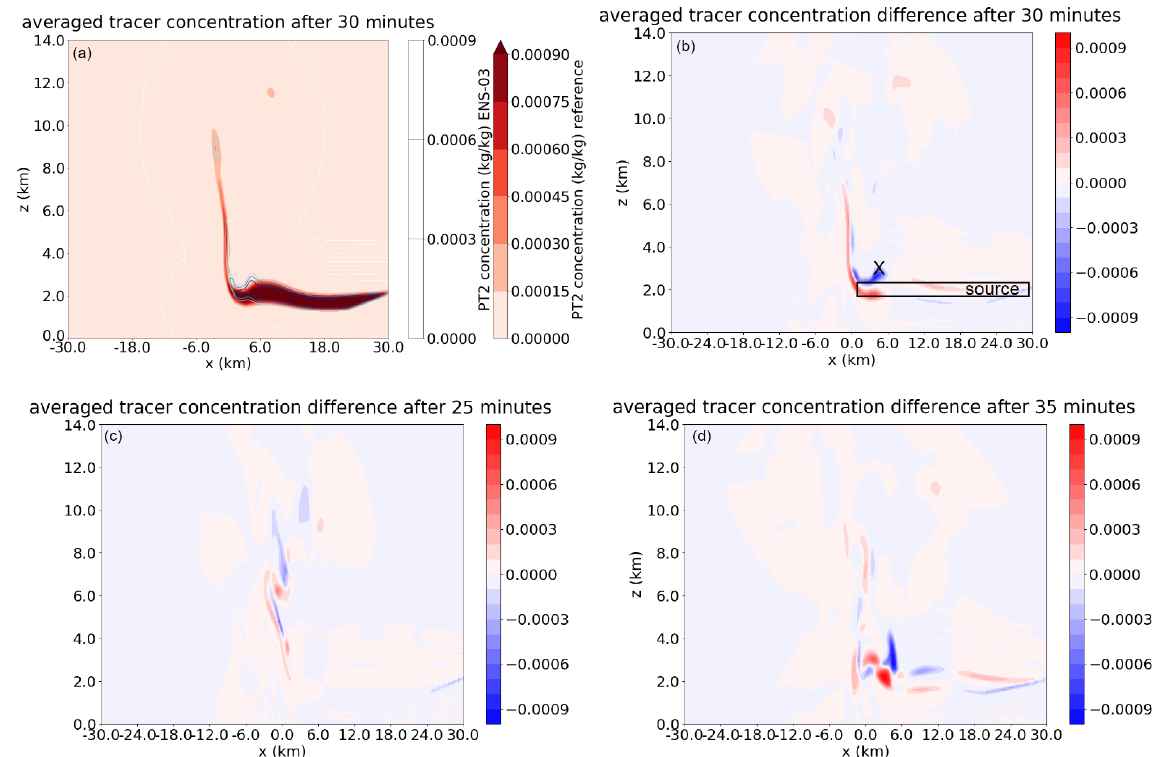
Figure 4. PT2 concentration in reference (shading) and ENS-03 (isolines) and PT2 concentration difference between reference and ENS-03 (reference minus ENS-03) after 30min (left, a , and right, b , at the top), 25min (left bottom, c ) and 35min (right bottom, d ). Red indicates a tracer surplus in reference simulation and blue in ENS-03. The black X (right, top, b ) marks the gravity wave crest in which vertical displacement leads to triggering of a new line of convective cells in the squall line, as we will see later. Note that only half of the 120km domain is shown.